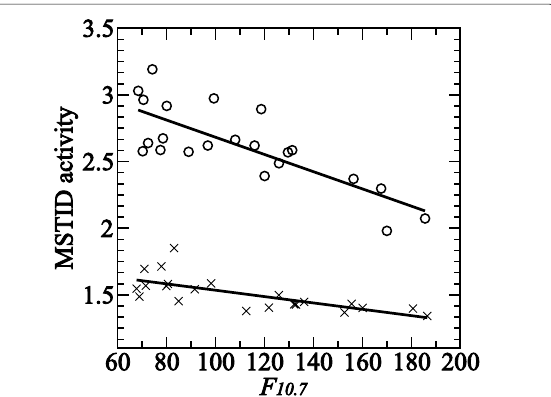
Fig. 7 Solar activity ( F 10.7 ) dependence of the MSTID activity for daytime (cross) and nighttime (circle). The daytime and nighttime MSTID activity for each year is an average of hourly MSTID activity over daytime (09–15 LT) in winter (January and December) and average over nighttime (19–01 LT) in summer (between May and August, respectively. Solid lines represent linear regression of the daytime and nighttime MSTID activity as a function of F 10.7 ,